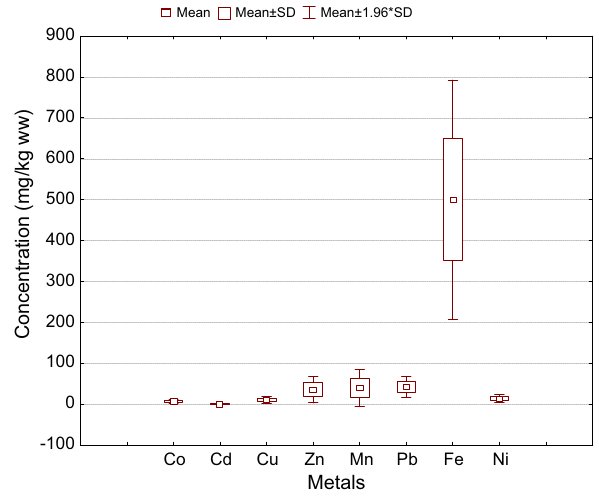
Fig. 3 Box and whisker plot showing variation heavy metals concen- trations in